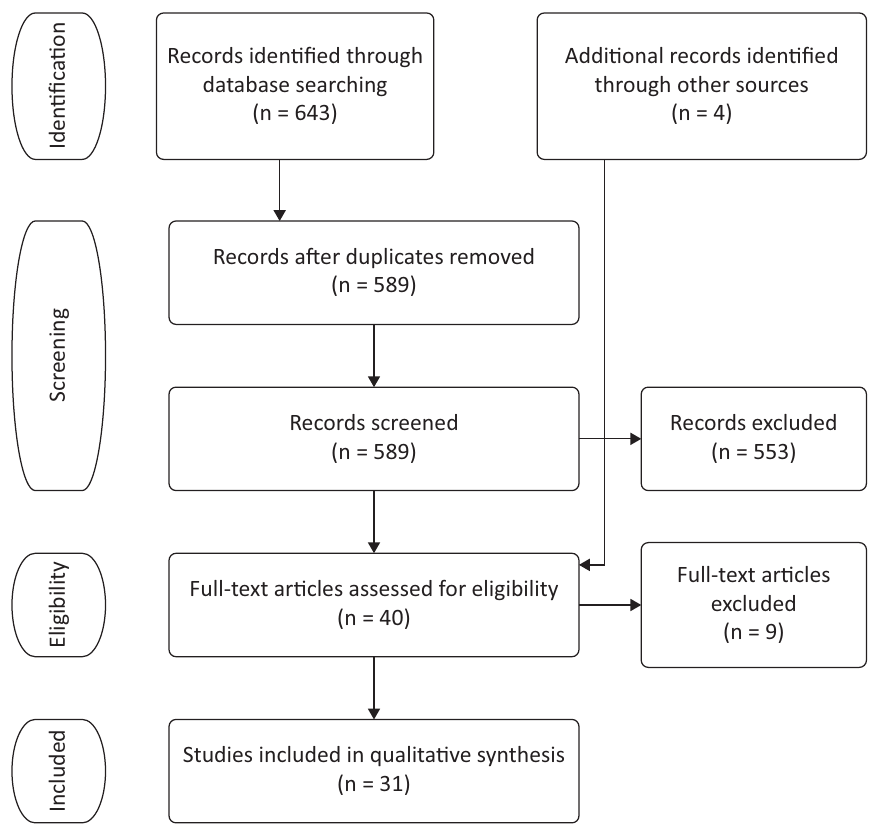
Figure 1. PRISMA flow diagram. Source: Flow diagram adapted from Moher et al. (2009). were unable to derive any understanding of the use of these